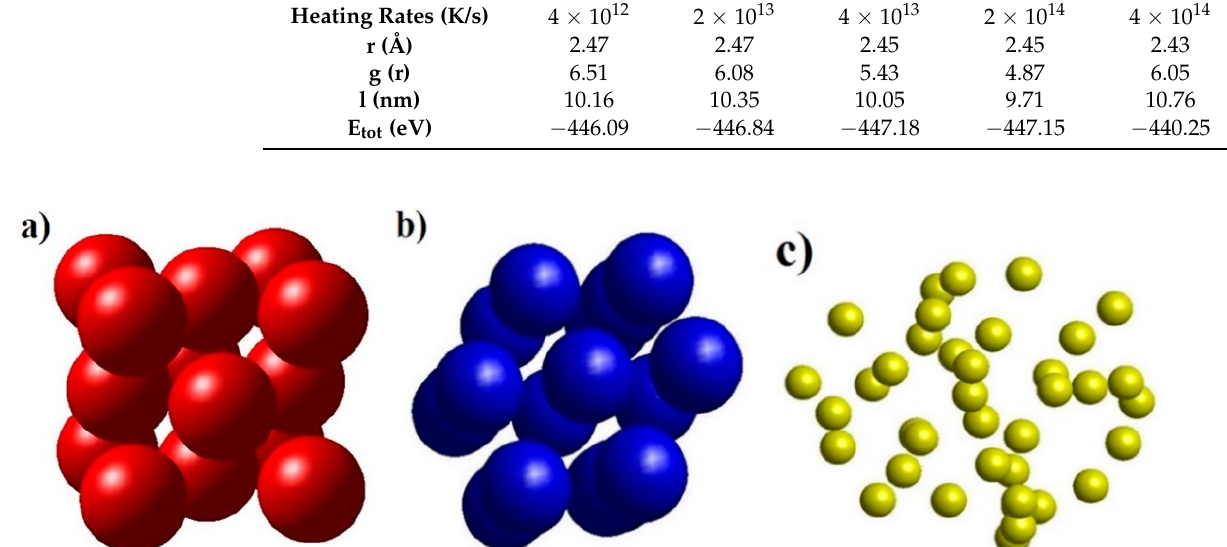
Figure 2. The structural unit number shape includes FCC structure ( a ), HCP structure ( b ), Amor structure ( c ) of NiAu alloy.